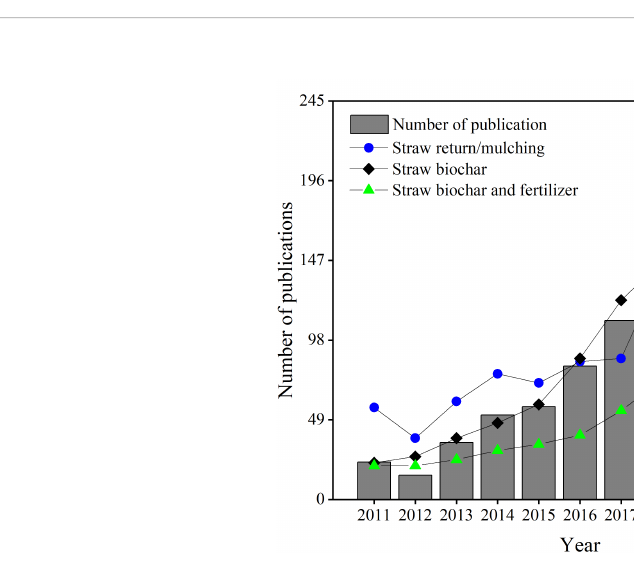
FIGURE 1 Publication performance during 2011 to